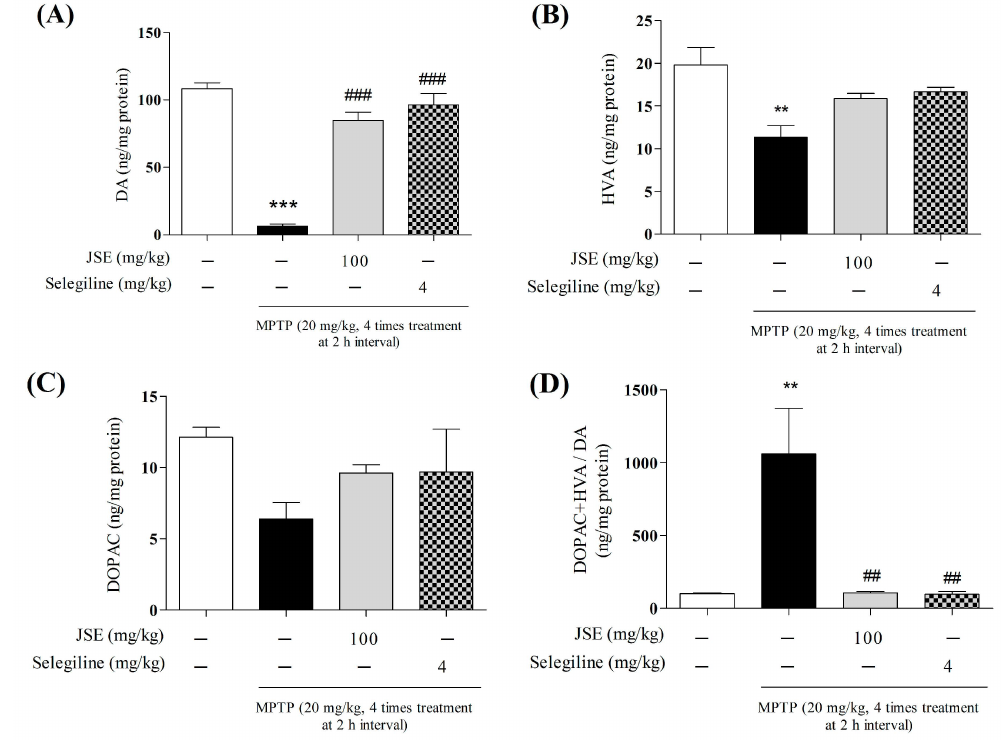
Figure 7. Effect of JSE on MPTP-induced changes neurotransmitter levels in the striatum (ST). JSE (100 mg/kg/day, dissolved in normal saline) was orally administered for six days. After 2 h for third day administration, MPTP (20 mg/kg) dissolved in saline was injected four times. Striatal levels of dopamine (DA) ( A ); homovanillic acid (HVA) ( B ); 3,4-dihydroxyphenylacetic acid (DOPAC) ( C ); and (DOPAC + HVA)/DA ( D ) were determined via HPLC analysis. Values were expressed as means ˘ SEM. ** p < 0.01 and *** p < 0.001 vs. the control group; ## p < 0.01 and ### p < 0.001 vs. the MPTP-only treated